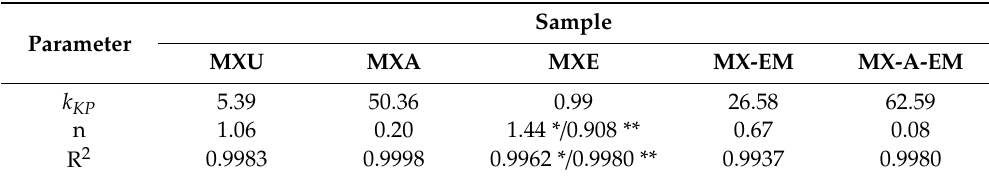
Table 9. The k KP (release constant), n (di ff usion exponent) and coe ffi cient of determination (R 2 ) values for the Korsmeyer-Peppas models applied to the meloxicam release kinetics.